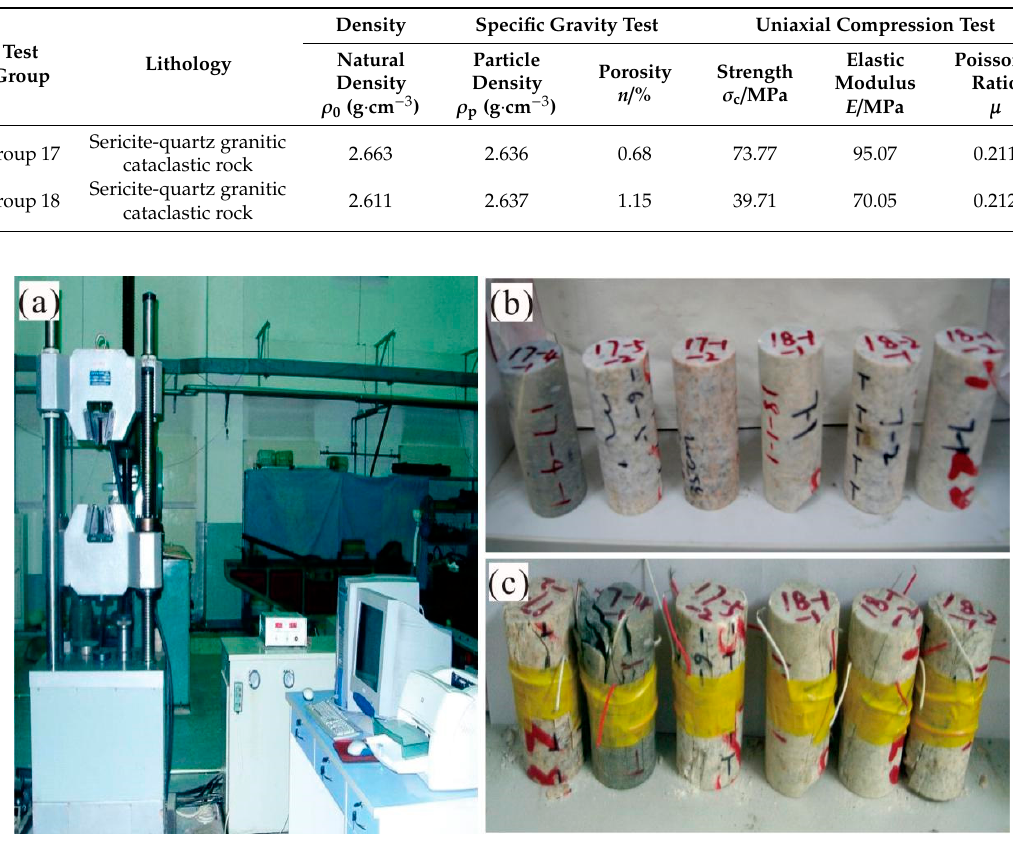
Figure 4. Laboratory test: ( a ) WES ‐ 2000 digital display hydraulic universal testing machine; ( b ) intact samples before the uniaxial compression test (UCT); and ( c ) failure mode after UCT.